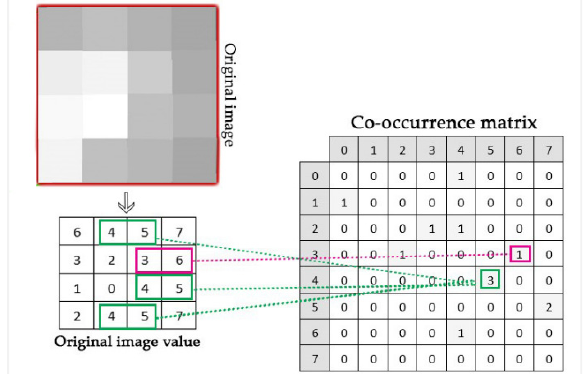
Figure 3. An example of Gray Level Co-occurrence Matrix (GLCM).